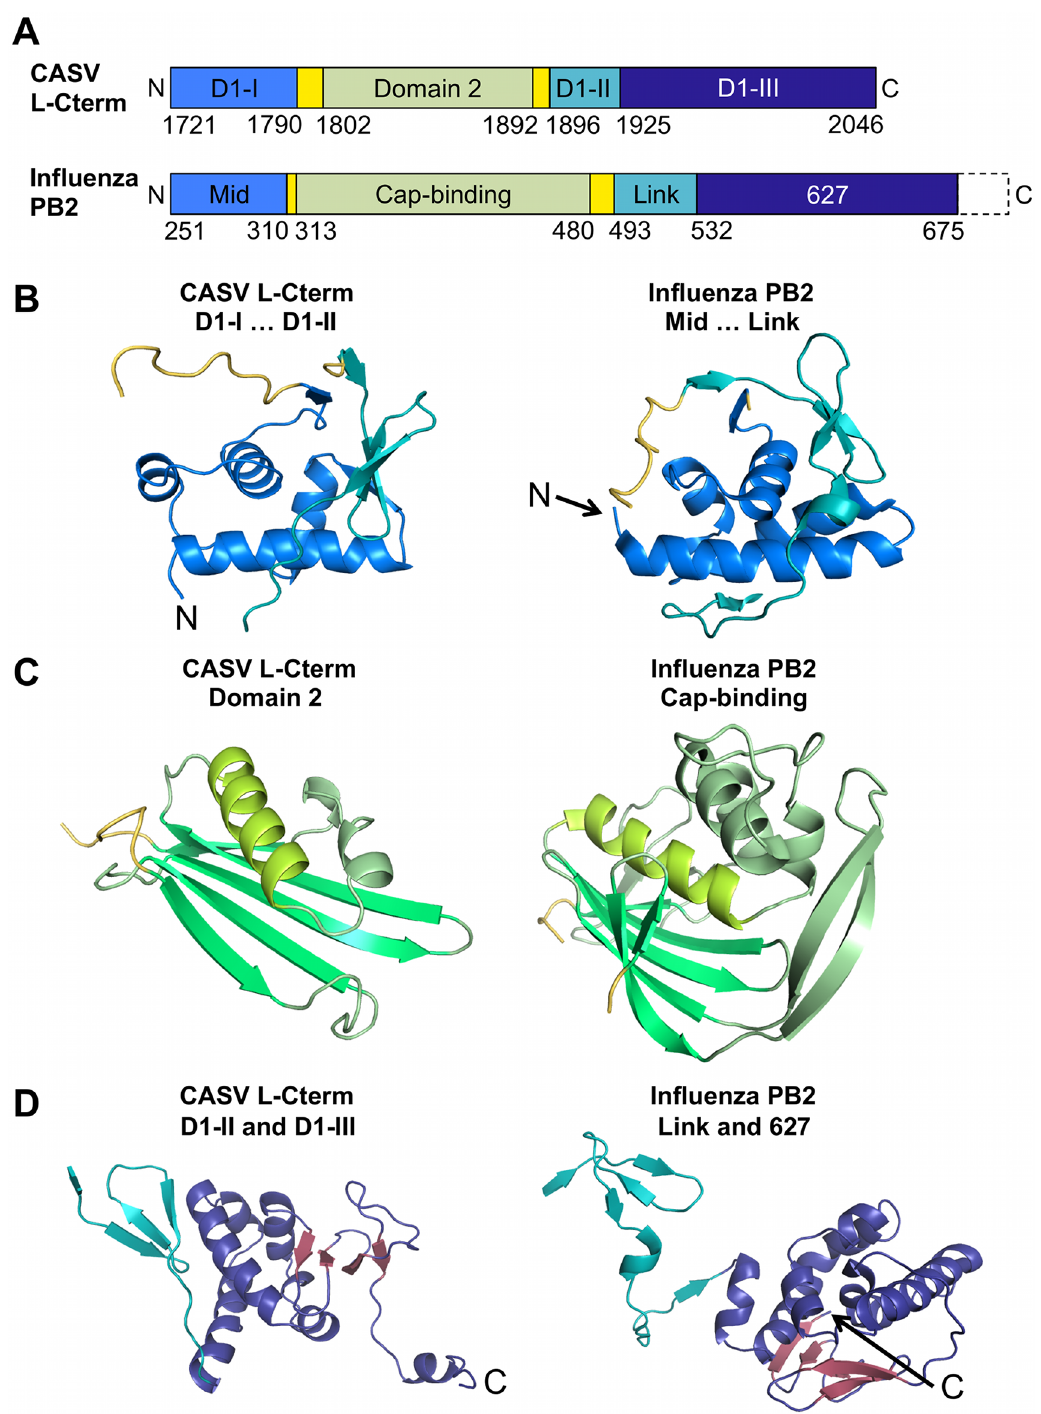
Fig 2. Comparison of CASV L-Cterm structure with influenza PB2 (PDB ID 5FMM) structure. A) Comparisonof domain arrangements within PB2 and L-Cterm. Identifiers of the areas within the protein are shown in the bars. Domain1 (D1) of L-Cterm is separated into three parts (D1-I, D1-II, and D1-III). Linkers to domain2 or the cap-bindingdomainare colored in yellow. Residuenumbersof the differentlycolored areas are given belowthe bars. N- and C-terminiare labelled.C-terminal parts of PB2 missing in the figure are indicatedby dashedlines. B) Structures of parts I and II of L-Cterm domain1 (left panel)and the mid-linkdomainsof PB2 (right panel)are shown as ribbondiagrams. Colors are